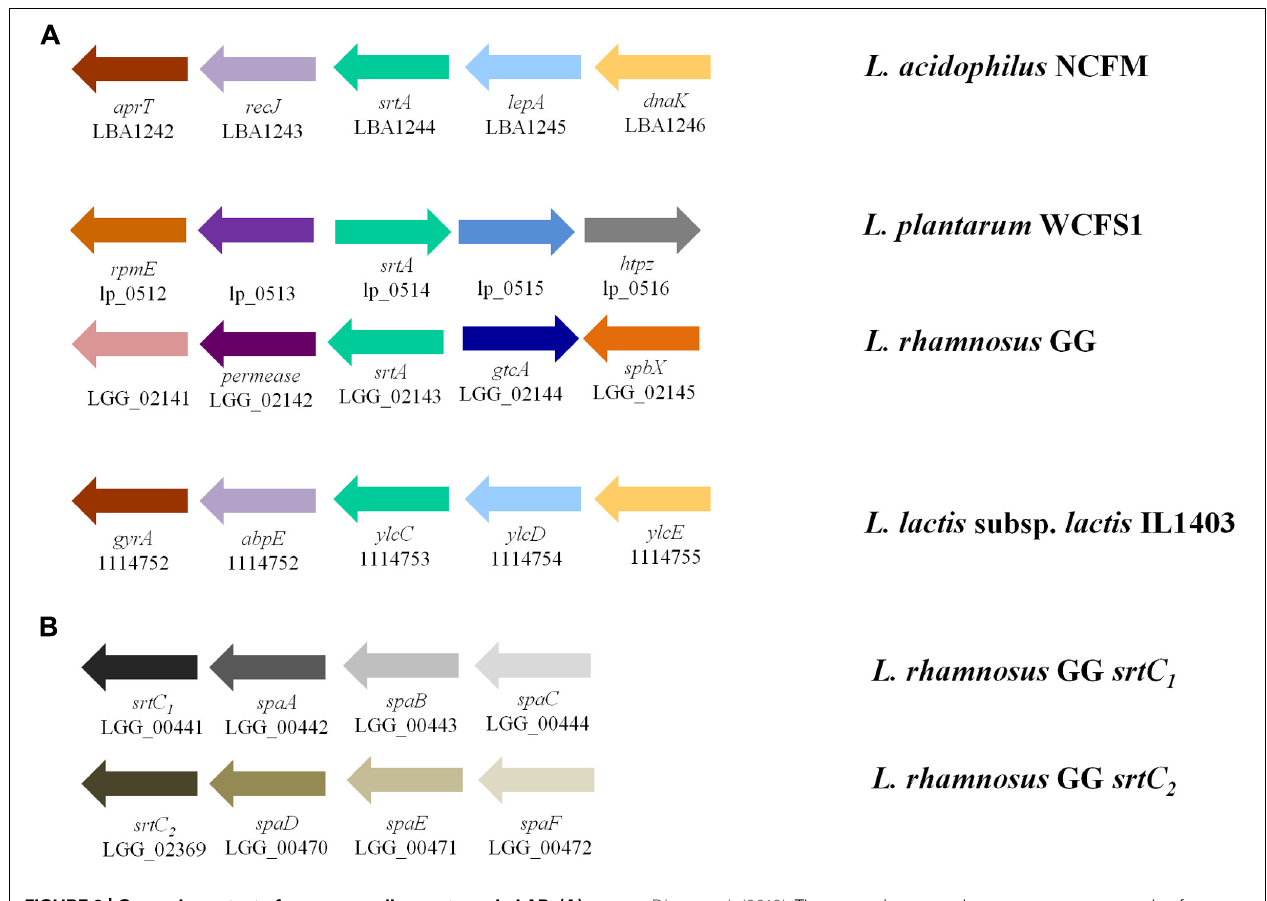
FIGURE 2 | Genomic context of genes encoding sortases in LAB. (A) Genomic context of sortase A (green arrow) as found in L. acidophilus NCFM, L. plantarum WCFS1, L. rhamnosus GG, and L. lactis subsp . lactis IL1403 vary greatly.The sortase in L. lactis is not yet annotated as such; however,